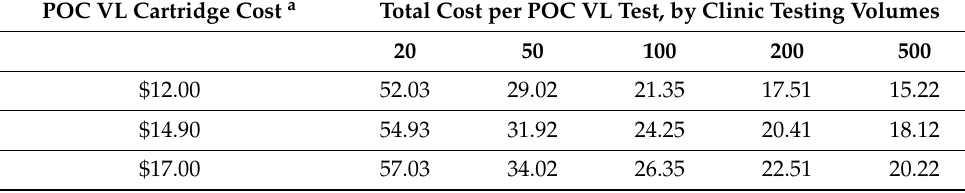
Table 2. Total per-test costs of HIV POC VL testing at varying cartridge costs and clinic testing